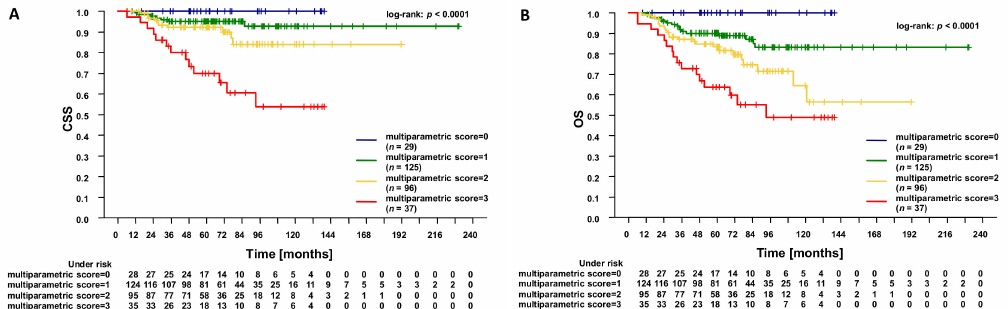
Figure 4. Kaplan–Meier plots for CSS ( A ) and OS ( B ), depending on a three parameter score consisting of the status of pCR, ypN, and OGG1 rs1052133. A multiparametric score of “0” was assigned if pCR was achieved, together with ypN0 and homozygosity for the wildtype allele at rs1052133. A score of “3” means that there was no pCR in combination with ypN+ and presence of the variant allele (either homo- or heterozygous). Accordingly, intermediate scores of “1” and “2” were derived for other combinations of the three considered parameters. Statistical assessment was performed by the log-rank